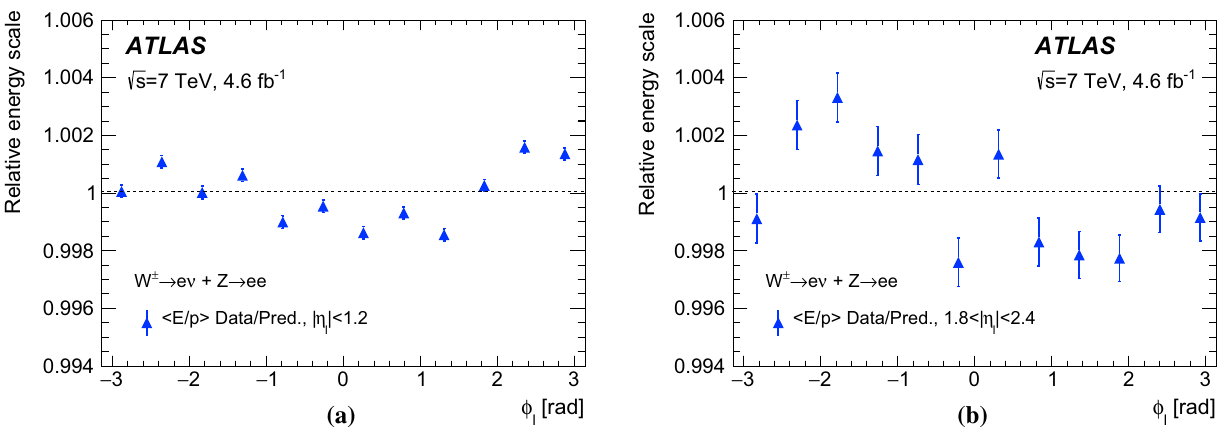
Fig. 8 Azimuthal variation of the data-to-prediction ratio of (cid:7) E / p (cid:8) in W and Z events, for electrons in a | η (cid:7) | < 1 . 2 and (b) 1 . 8 < | η (cid:7) | < 2 . 4. The electron energy calibration based on Z → ee events is applied, and